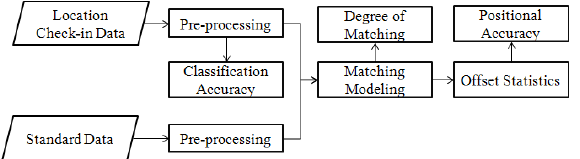
Figure 1. Flow chart of the quality